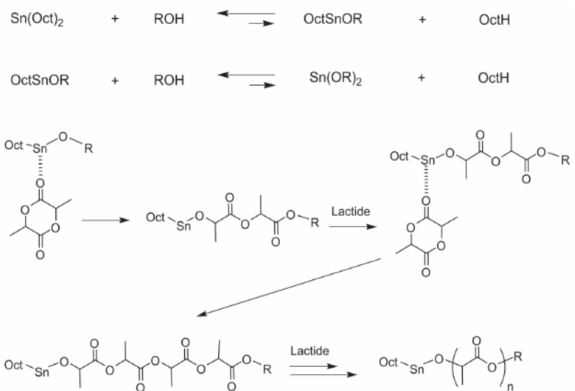
Figure 2. ROP of lactide by Sn(Oct) 2 by the coordination-insertion mechanism. Reproduced with permission from Ref. [35]. Copyright 2015, The Royal Society of Chemistry.